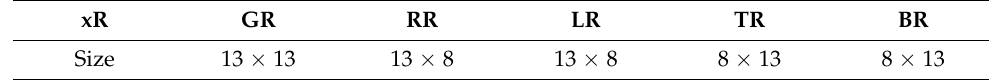
Table 3. The size of windows of DRCNN. xR